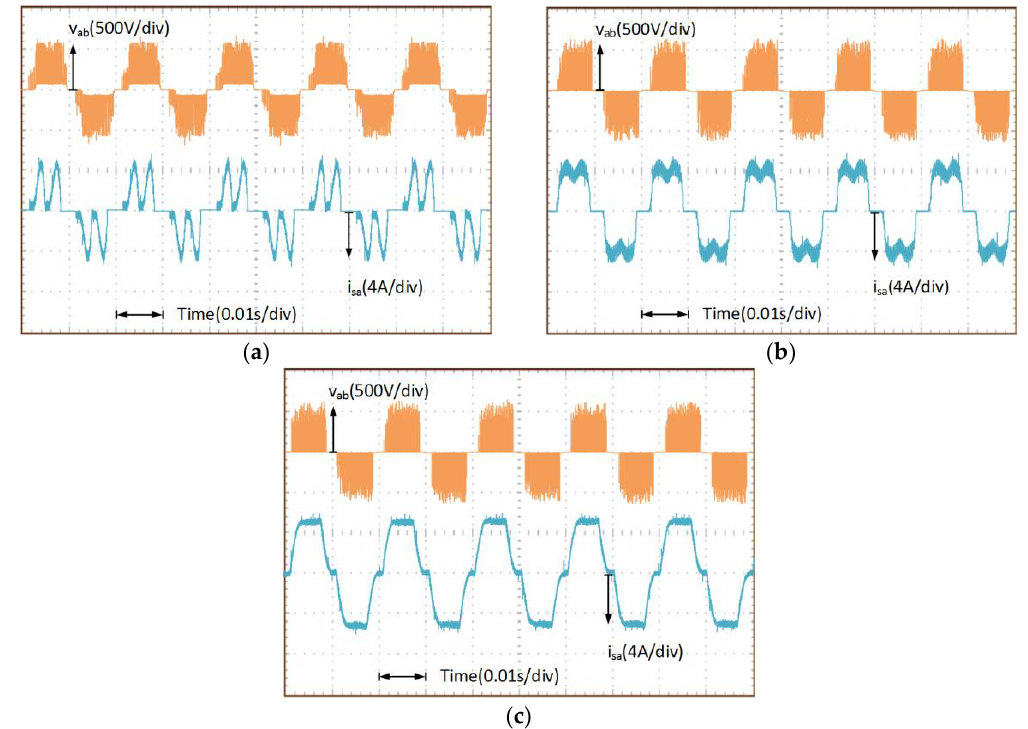
Figure 14. Experimental waveforms of the grid-side in half quasi-Z-source WPGS. The experimental waveforms of the stator voltage and stator current of the PMSG with Z- source inverter, quasi-Z-source inverter and half quasi-Z-source inverter are shown in Figure 15.